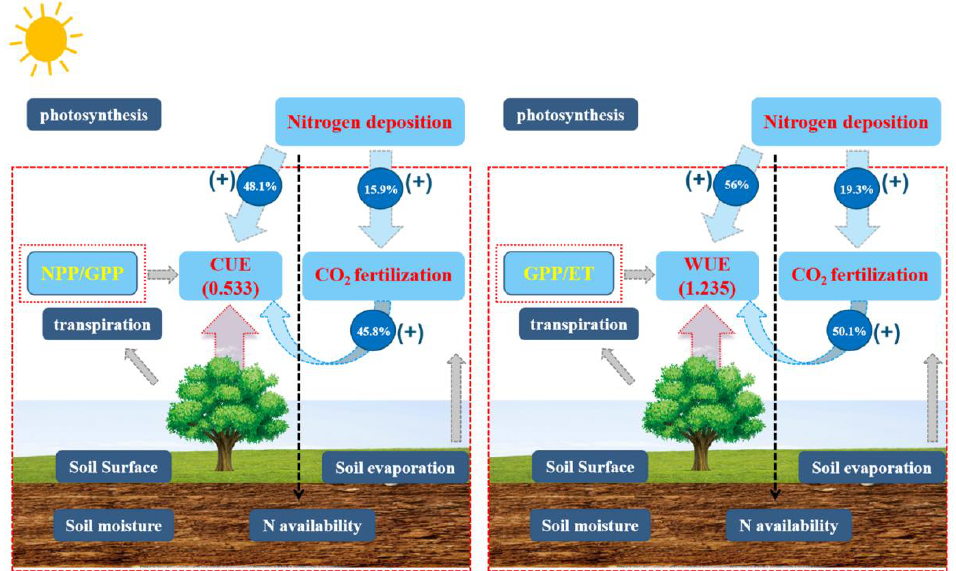
Figure 10. Mechanistic diagram of the effect of ND and CO 2 on CUE and WUE.